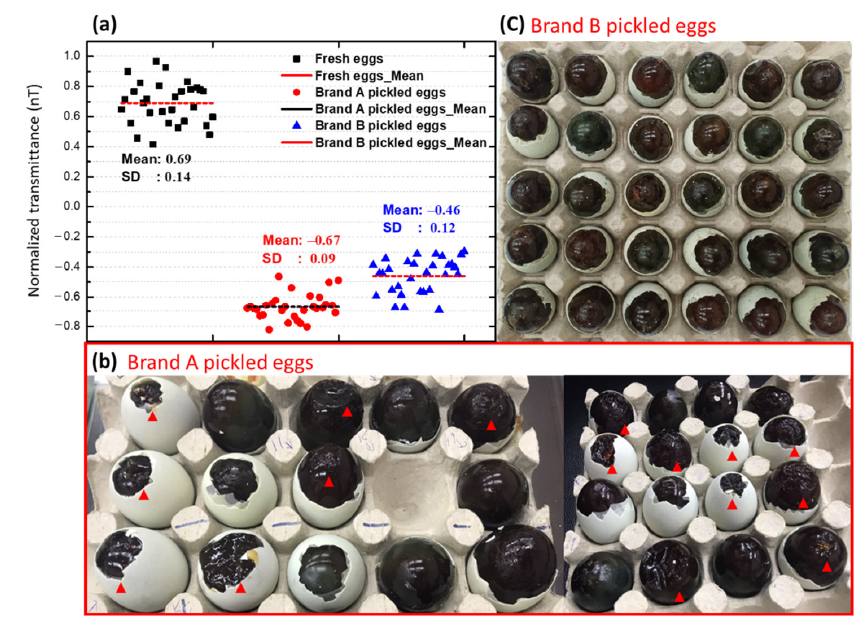
Figure 9. ( a ) 590 ± 3 nm band normalized transmittance spectrum validation scatter diagram of fresh duck eggs and commercially available preserved eggs. ( b ) Brand A preserved eggs after the removal of the shell (the red triangle is marked as gel failure). ( c ) Brand B preserved eggs after the removal of the shell, and all preserved eggs were successfully